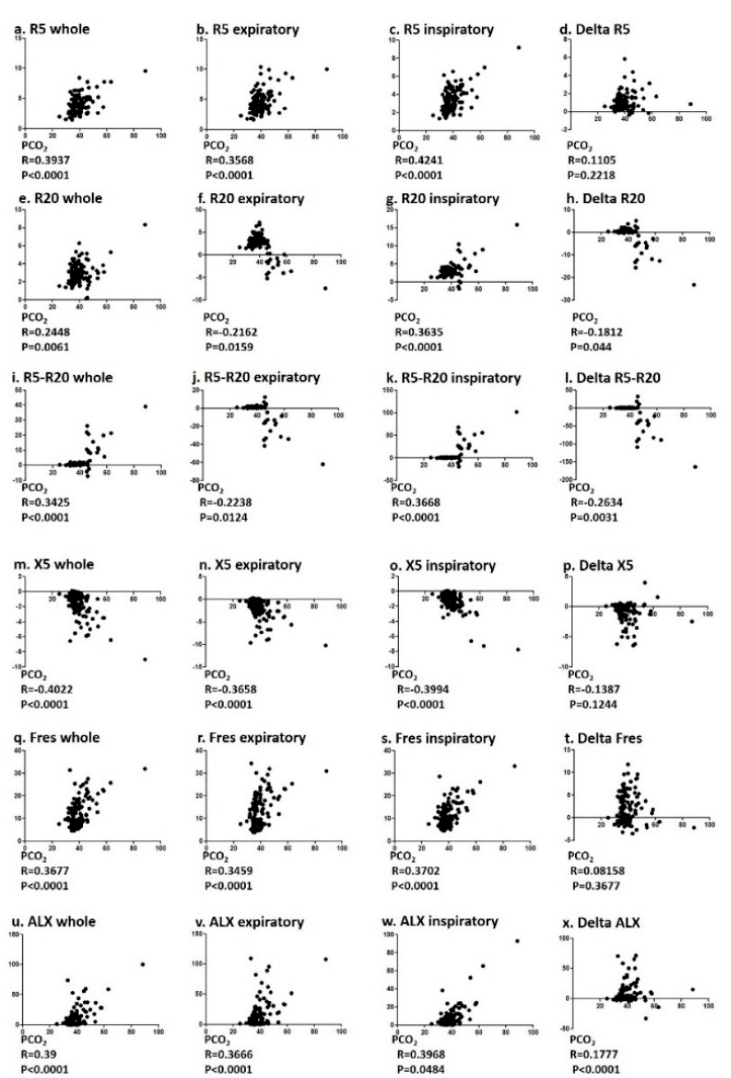
Figure 2. Correlation between PCO 2 and FOT values. Specifically, correlation between PCO 2 ( a – d ) R5, ( e – h ) R20, ( i – l ) R5-R20, ( m – p ) X5, ( q – t ) Fres, and ( u – x ) ALX were analyzed using Spearman rank